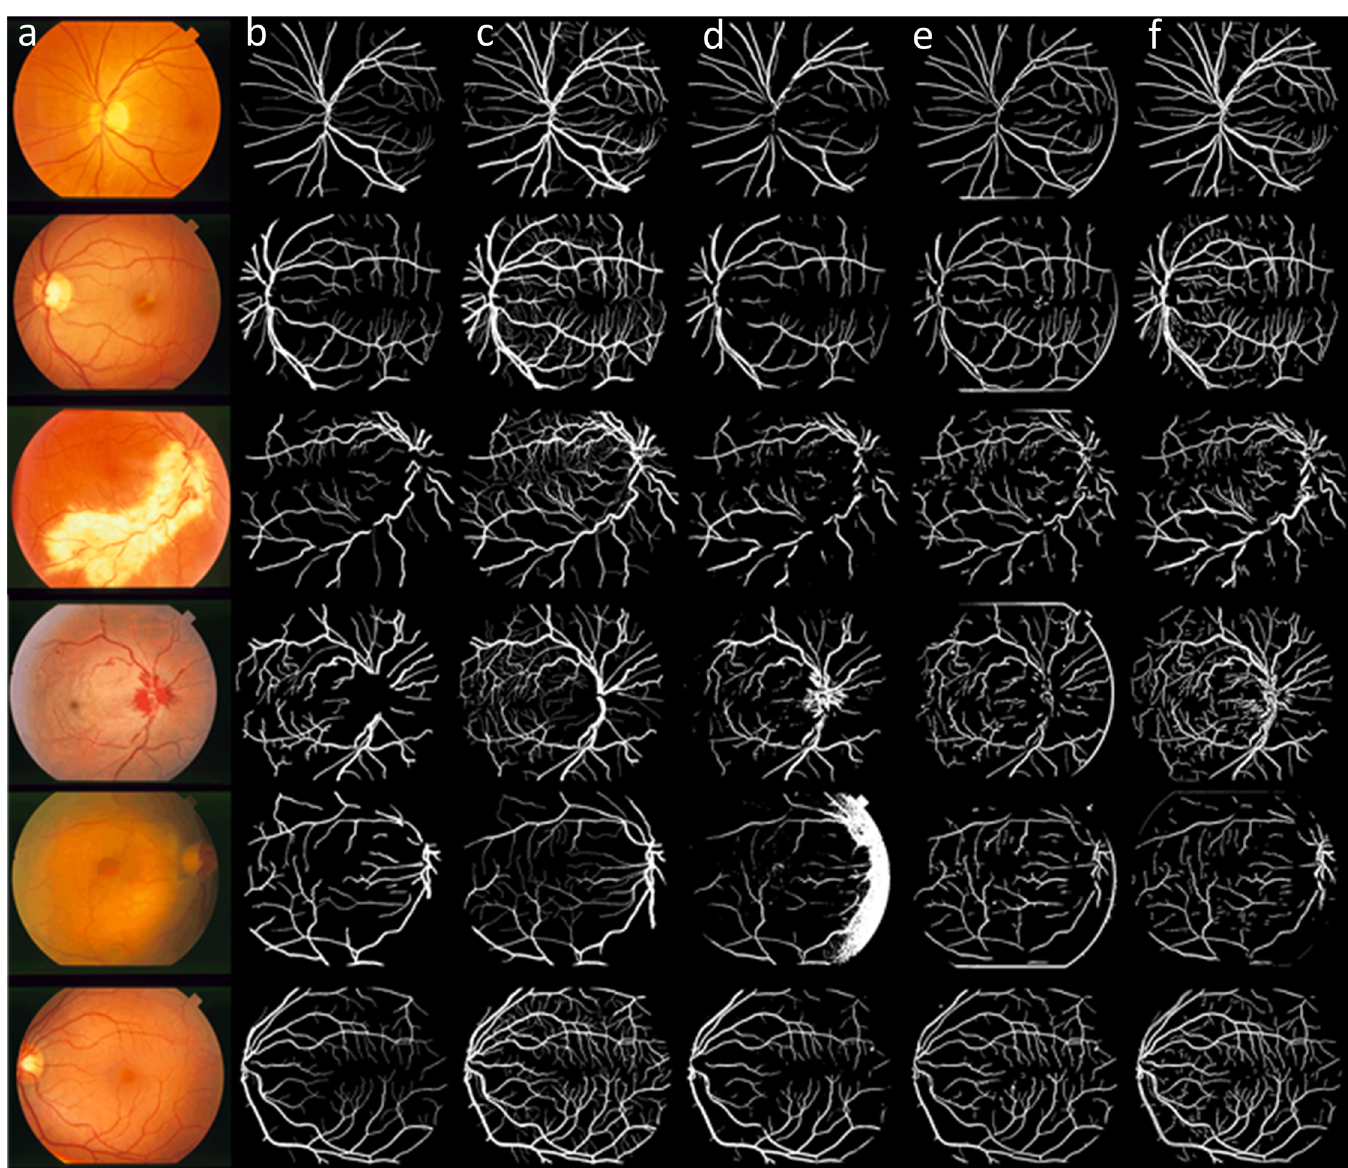
Fig 9. Results of the different methods applied to the STARE dataset: (a) original image; (b) manually segmented images; (c) Manually segmented image with more small vessels. (d-e) Result of the methods reported in references [9] and [18]. (f) Results of the proposed